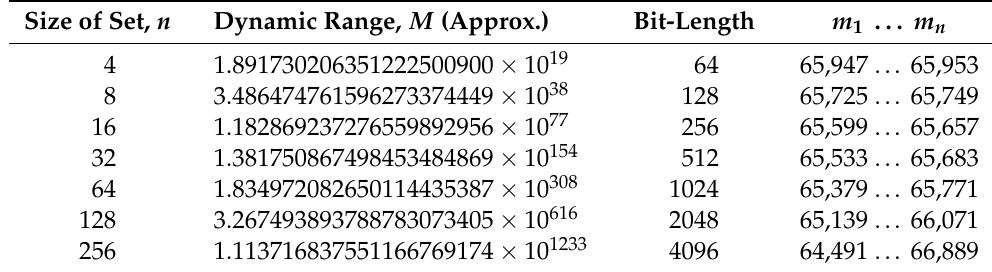
Table 2. Overview of the moduli sets used in the experiments. Size of Set, n